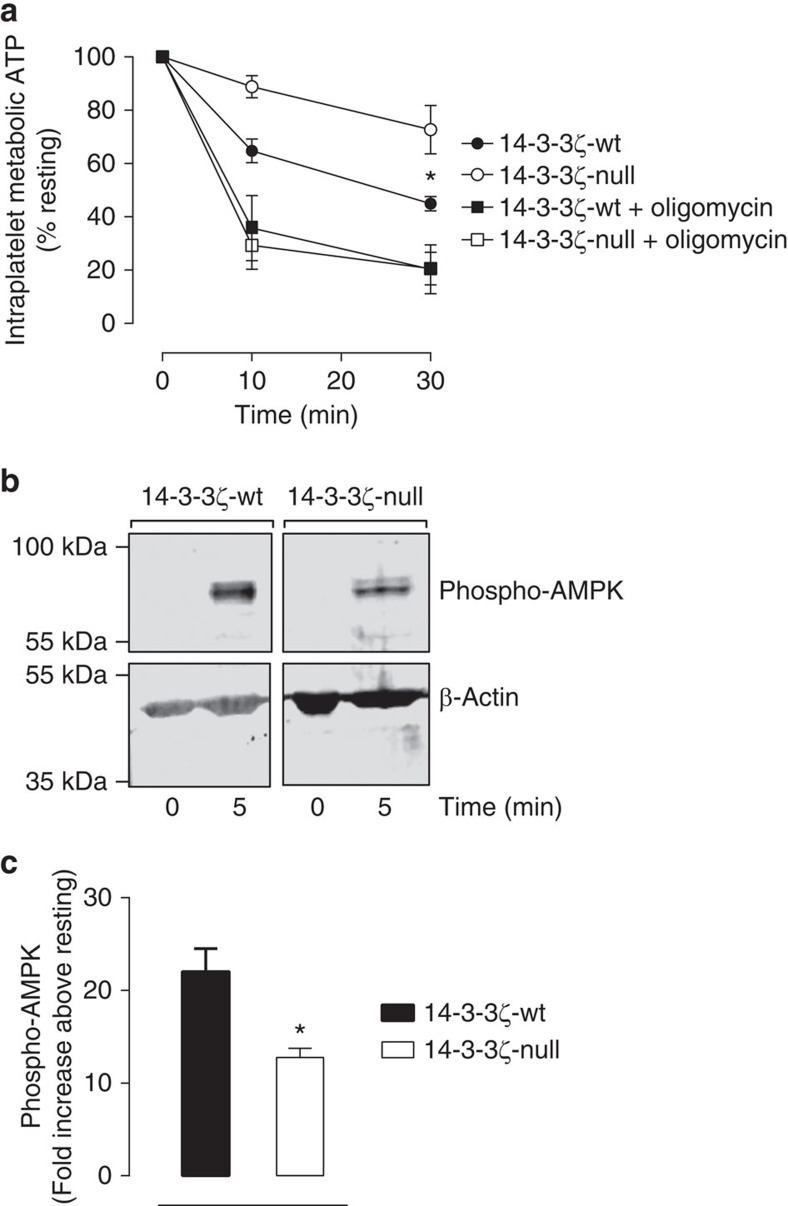
14-3-3ζ-deficient platelets demonstrate sustained metabolic ATP following potent activation.(a) Washed platelets (1 × 108 ml−1) were isolated from 14-3-3ζ-wt (black symbols) or 14-3-3ζ-deficient (14-3-3ζ-null) (white symbols). Where indicated (squares), platelets were pre-incubated with oligomycin (1 μM), prior to stimulation. Metabolic ATP was extracted and quantified in unstimulated (Resting) and stimulated platelets with a mix of CRP (0.25 μg ml−1) and thrombin (0.5 U ml−1) for up to 1,800 s as described in ‘Methods’ section. Results are expressed as the percentage (%) change in ATP compared with resting control levels over the indicated times, and represent the mean±s.e.m. (n=4). A two-way ANOVA was used to determine statistical difference between 14-3-3ζ-wt and 14-3-3ζ-null platelets (NSP>0.05; *P<0.05). (b,c) Western blot analysis of phospho-AMPK in 14-3-3ζ-wt and 14-3-3ζ-null platelets: Washed platelets (3 × 108 ml−1) were isolated from 14-3-3ζ-wt and 14-3-3ζ-null mice and activated with CRP/thrombin (0.25 μg ml−1, 1 U ml−1). After activation, platelets were lysed using RIPA buffer. Platelet lysates were analysed by western blot analysis of phospho-AMPK protein using a phosphospecific antibody (40H9). The western blot in b is taken from one representative of three independent experiments. Total β-actin was used as a loading control, and quantification of phospho-AMPK signal was expressed as a ratio of protein loading (c, mean±s.e.m., n=3), using LICOR technology. A Student’s t-test was used to determine statistical difference between 14-3-3ζ-wt and 14-3-3ζ-null platelets (*P<0.05). Where appropriate, results were analysed using either unpaired Student’s t-test, two-way ANOVA with Tukey’s post hoc testing.